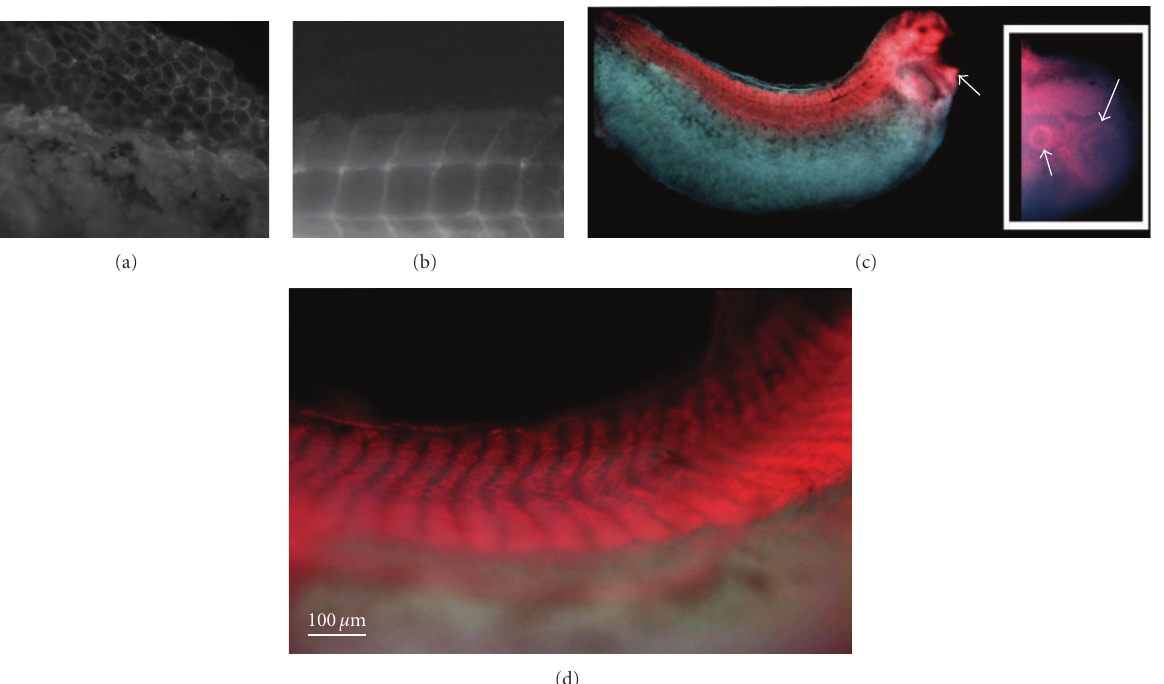
Figure 1: Proteinase K treatment is necessary to allow QD penetration and labeling of deep tissues in Xenopus and QD705 nm anti-Dig conjugates can be used for the detection of transcripts in wholemount in situ hybridization experiments. (a) Detection of biotinylated 4G10 (anti-Phosphotyrosine) antibody using streptavidin conjugated 655nm QDs in a triton permeabilized embryo. Specific staining can be seen at the cell-cell boundaries of the ectodermal cells of the fin (upper part of the image) but not in the deep tissues (somites at the bottom part of the image). (b) Detection of biotinylated 4G10 (anti-Phosphotyrosine) antibody using streptavidin conjugated 655 nm QDs in a PK permeabilized embryo. Specific staining of the deep intersomitic boundaries can be seen. Superficial cells of the fin cannot be seen due to degradation of this delicate structure by the PK treatment. (c) QD705 nm anti-DIG antibody labeling of the probe for LTBP1 generates a staining pattern that closely matches the published expression for this mRNA [1]. QDs label the somites as well as anterior neural and neural crest tissues including the branchial arches and a region surrounding the eye. (d) Imaging of the QD labeling for LTBP1 in the somites at 10X magnification.